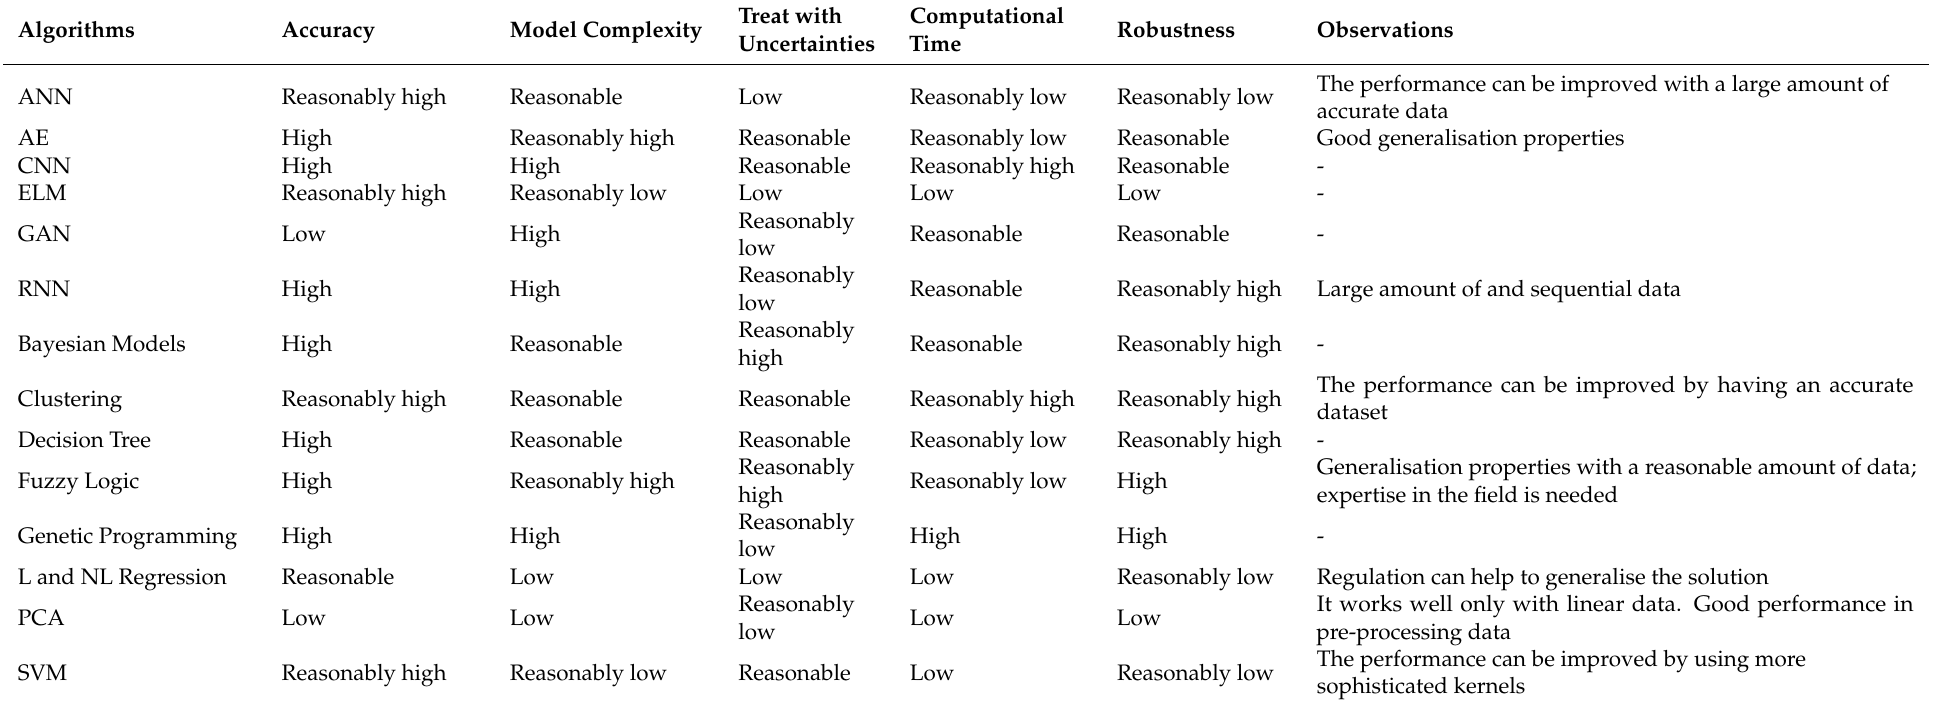
Table 6. Comparative study of the presented machine-learning-based